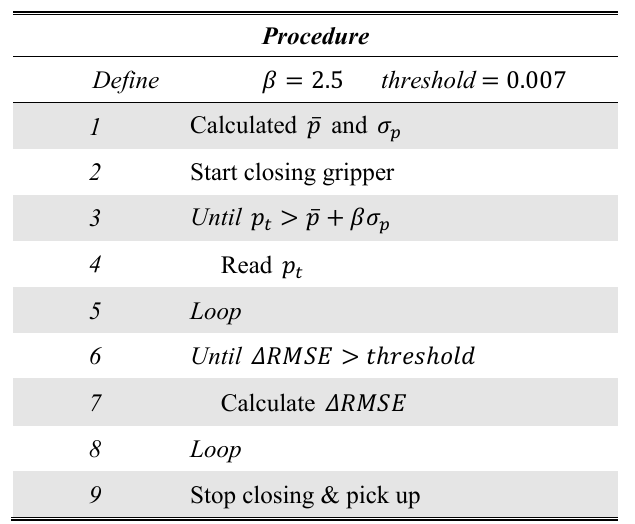
Figure 5. Behavior of the fluid pressure in the compression tests for soft tofu [4].